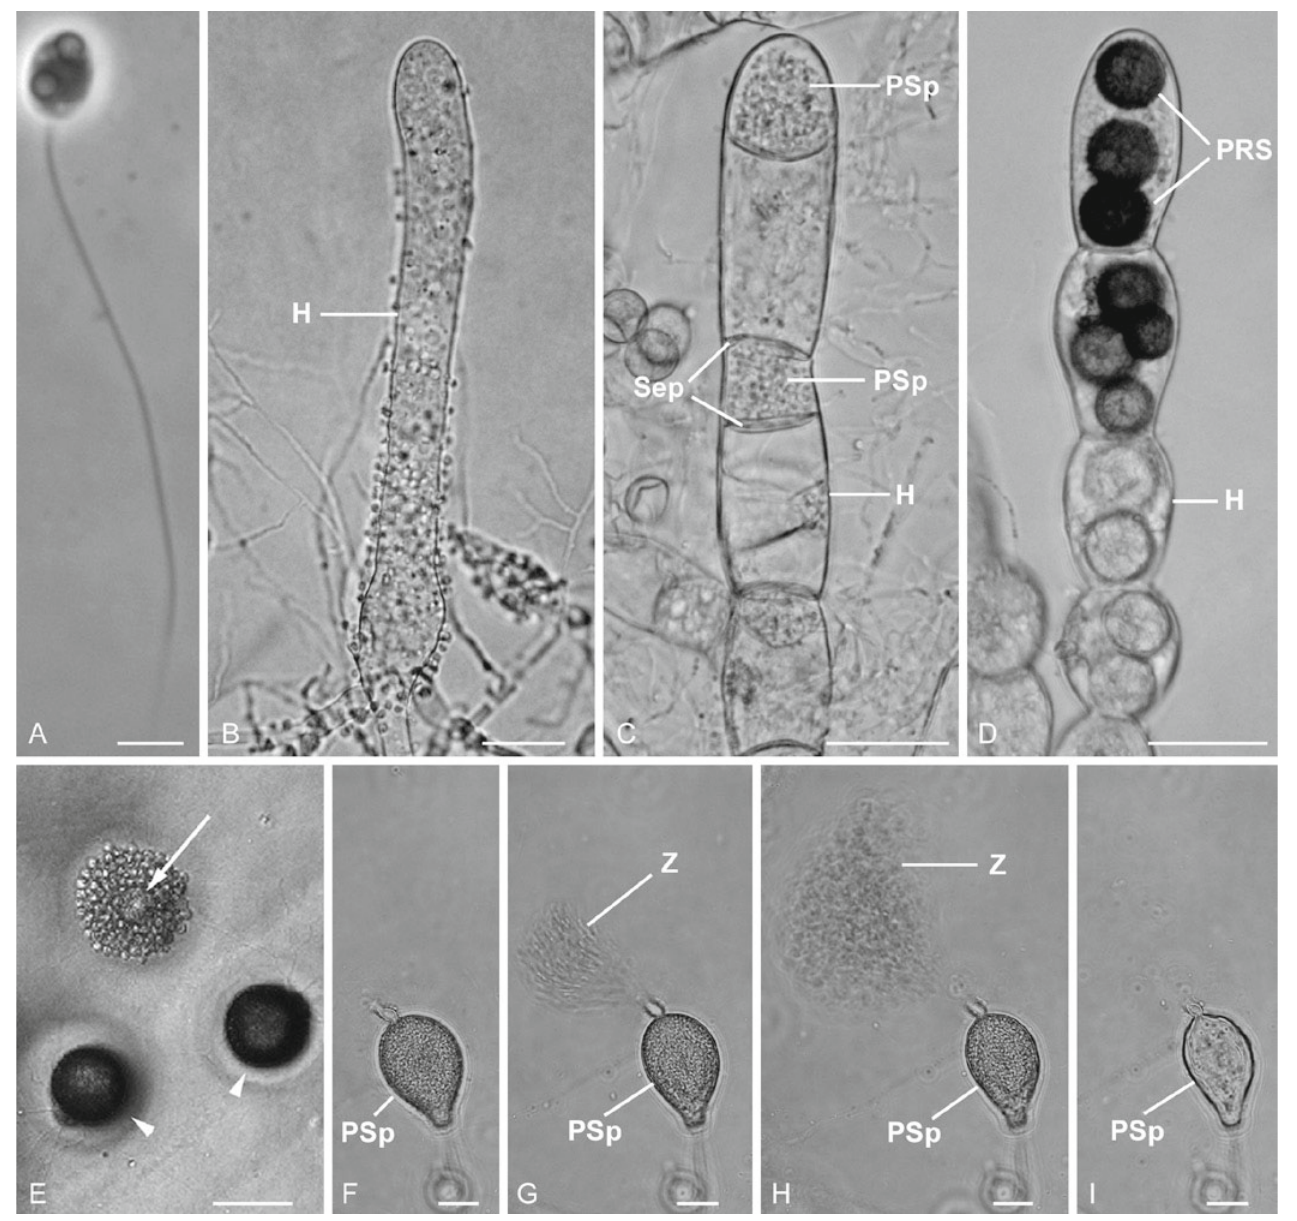
Fig. 1. Light microscopic images of Rozella . A. (cid:2)(cid:134)(cid:4)(cid:8)(cid:11)(cid:23)(cid:13)(cid:2)"(cid:4)(cid:4)(cid:7)(cid:18)(cid:4)(cid:10)(cid:13)(cid:2)(cid:4)(cid:26)(cid:2) R. rhizoclosmatii [strain JEL 863, Letcher et al. 2017]. B–D. R. allomycetis and its host Allomyces macrogynus [strain UM690, unpubl.]. B. (cid:2)V(cid:17)(cid:19)(cid:22)(cid:7)(cid:8)(cid:13)(cid:21)(cid:2)"(cid:4)(cid:4)(cid:7)(cid:18)(cid:4)(cid:10)(cid:13)(cid:7)(cid:2)(cid:4)(cid:17)(cid:2)(cid:14)(cid:4)(cid:7)(cid:8)(cid:2)(cid:14)(cid:22)(cid:18)(cid:14)(cid:9)(cid:28)(cid:2) C. Parasite sporangia in septate segments of host hypha. D. Spiny parasite resting spores in septate segments of host hypha. E. Rozella rhizoclosmatii . Uninfected sporangium of host Rhizoclosmatium globosum (cid:29)(cid:2)(cid:15)(cid:11)(cid:8)(cid:14)(cid:2)(cid:21)(cid:11)(cid:7)(cid:19)(cid:14)(cid:9)(cid:10)(cid:25)(cid:13)(cid:21)(cid:2)"(cid:4)(cid:4)(cid:7)(cid:18)(cid:4)(cid:10)(cid:13)(cid:7)(cid:2)(cid:24)(cid:9)(cid:10)(cid:10)(cid:4)(cid:15)(cid:27)(cid:30)(cid:2)(cid:11)(cid:17)(cid:26)(cid:13)(cid:19)(cid:8)(cid:13)(cid:21)(cid:29)(cid:2)(cid:14)(cid:22)(cid:18)(cid:13)(cid:10)(cid:8)(cid:10)(cid:4)(cid:18)(cid:14)(cid:11)(cid:13)(cid:21)(cid:2)(cid:14)(cid:4)(cid:7)(cid:8)(cid:2)(cid:7)(cid:18)(cid:4)(cid:10)(cid:9)(cid:17)(cid:25)(cid:11)(cid:9)(cid:2)(cid:24)(cid:9)(cid:10)(cid:10)(cid:4)(cid:15)(cid:14)(cid:13)(cid:9)(cid:21)(cid:7)(cid:27)(cid:2)(cid:147)(cid:7)(cid:8)(cid:10)(cid:9)(cid:11)(cid:17)(cid:2)(cid:139)V^(cid:2)+(cid:148)@(cid:29)(cid:2)^(cid:13)(cid:8)(cid:19)(cid:14)(cid:13)(cid:10)(cid:2) et al . 2017]. F–I. Rozella multimorpha (cid:28)(cid:2)(cid:130)(cid:4)(cid:4)(cid:7)(cid:18)(cid:4)(cid:10)(cid:13)(cid:2)(cid:10)(cid:13)(cid:23)(cid:13)(cid:9)(cid:7)(cid:13)(cid:2)(cid:26)(cid:10)(cid:4)(cid:6)(cid:2)(cid:8)(cid:13)(cid:10)(cid:6)(cid:11)(cid:17)(cid:9)(cid:23)(cid:2)(cid:7)(cid:18)(cid:4)(cid:10)(cid:9)(cid:17)(cid:25)(cid:11)(cid:5)(cid:6)(cid:2)(cid:11)(cid:17)(cid:2)(cid:11)(cid:17)(cid:26)(cid:13)(cid:19)(cid:8)(cid:13)(cid:21)(cid:2)(cid:14)(cid:4)(cid:7)(cid:8)(cid:2) Pythium catenulatum [strain JEL 883, unpublished; see Letcher et al (cid:28)(cid:2)(cid:31)X*+G(cid:28)(cid:2)U(cid:12)(cid:12)(cid:10)(cid:13)%(cid:11)(cid:9)(cid:8)(cid:11)(cid:4)(cid:17)(cid:7)$(cid:2)BO(cid:29)(cid:2)(cid:19)(cid:4)(cid:17)(cid:19)(cid:13)(cid:17)(cid:8)(cid:10)(cid:11)(cid:19)(cid:2)(cid:12)(cid:4)(cid:21)(cid:11)(cid:13)(cid:7)(cid:30)(cid:2)\(cid:29)(cid:2)(cid:14)(cid:4)(cid:7)(cid:8)(cid:30)(cid:2)(cid:133)Q(cid:18)(cid:29)(cid:2)(cid:18)(cid:9)(cid:10)(cid:9)(cid:7)(cid:11)(cid:8)(cid:13)(cid:2)(cid:7)(cid:18)(cid:4)(cid:10)(cid:9)(cid:17)(cid:25)(cid:11)(cid:5)(cid:6)(cid:30)(cid:2)(cid:133)(cid:143)Q(cid:29)(cid:2)(cid:18)(cid:9)(cid:10)(cid:9)(cid:7)(cid:11)(cid:8)(cid:13)(cid:2)(cid:10)(cid:13)(cid:7)(cid:8)(cid:11)(cid:17)(cid:25)(cid:2)(cid:7)(cid:18)(cid:4)(cid:10)(cid:13)(cid:30)(cid:2)